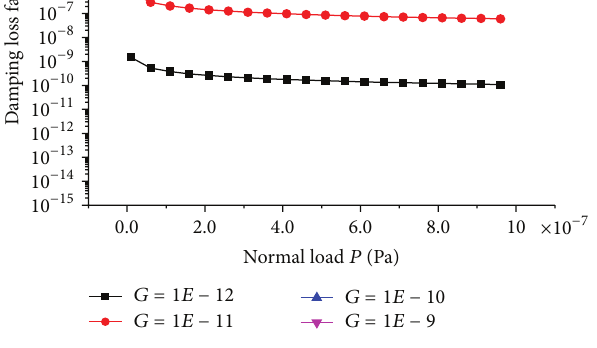
Figure 7: Relationships between 𝜂 and 𝑃 .